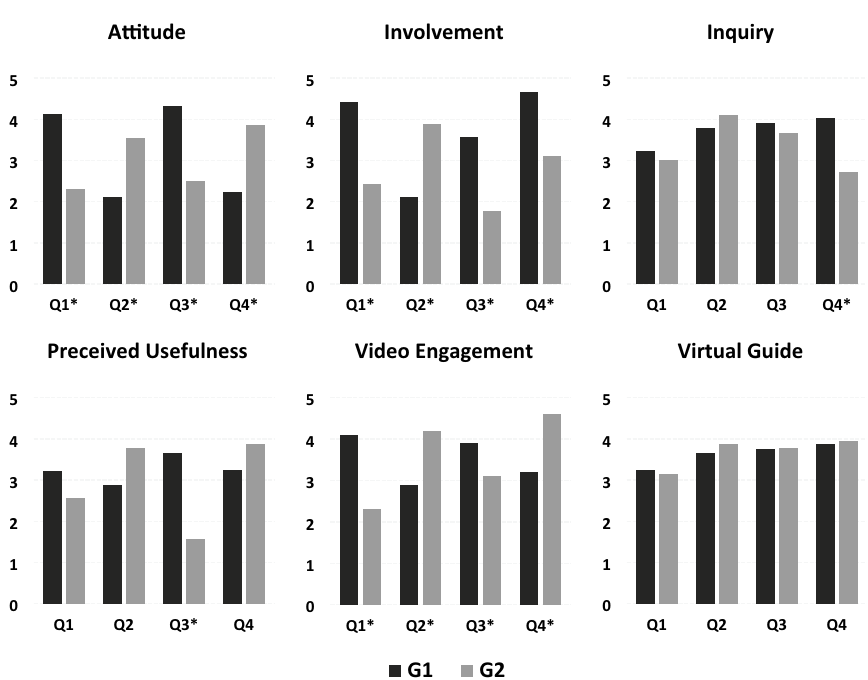
Fig. 3 Between-group comparison of VFT-XP mean scores. *Any quarter where mean scores are statistically